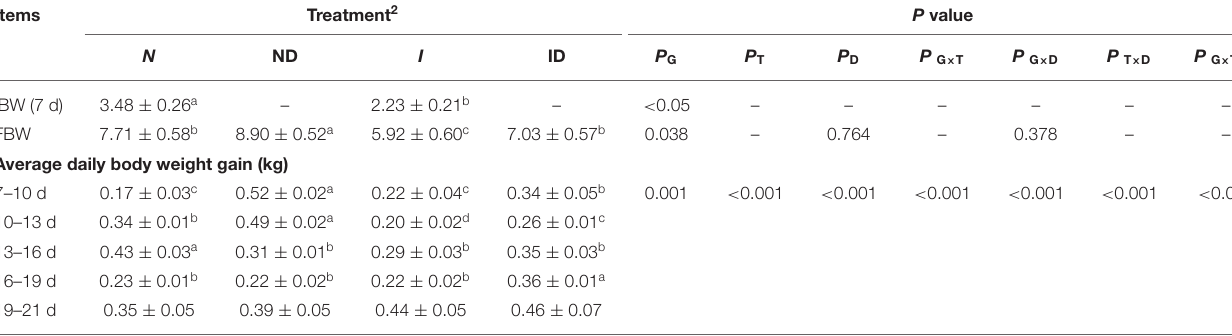
TABLE 1 | Supplementation with DMG-Na improved the growth performance of IUGR suckling piglets 1 . Items Treatment 2